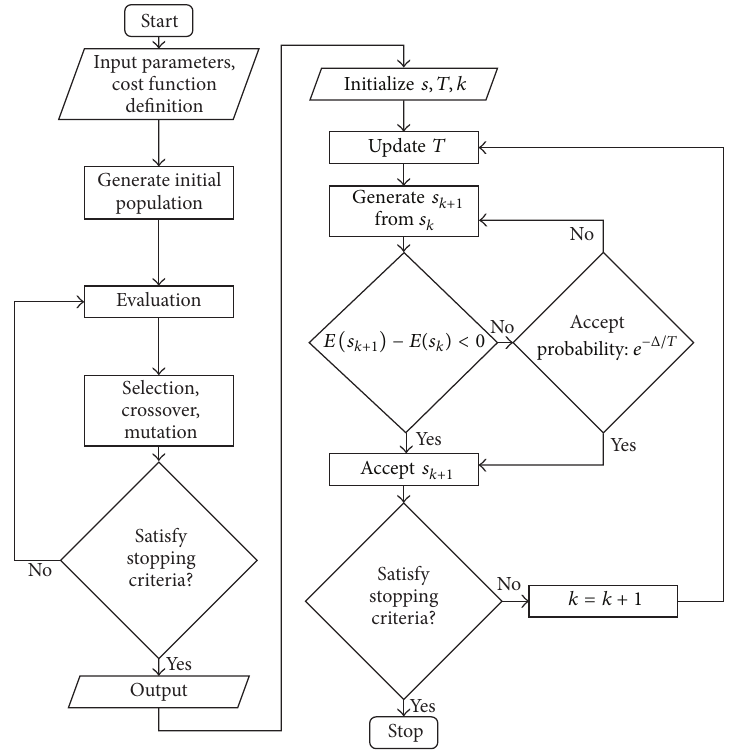
Figure 3: Flowchart of Genetic Simulated Annealing